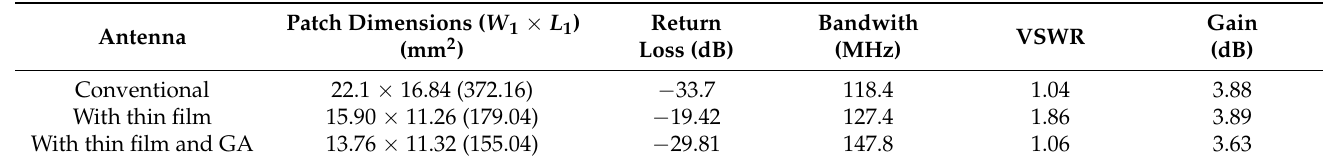
Table 2. Comparison of the proposed microstrip patch antenna operating at 4 GHz with the conven- tional antenna, antenna with a thin film, and antenna with a thin film optimized by GA. Antenna